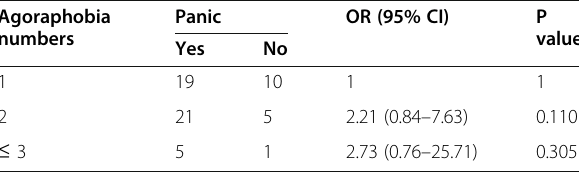
Table 3 Numbers of agoraphobia situations and its association with panic disorder in the study participants